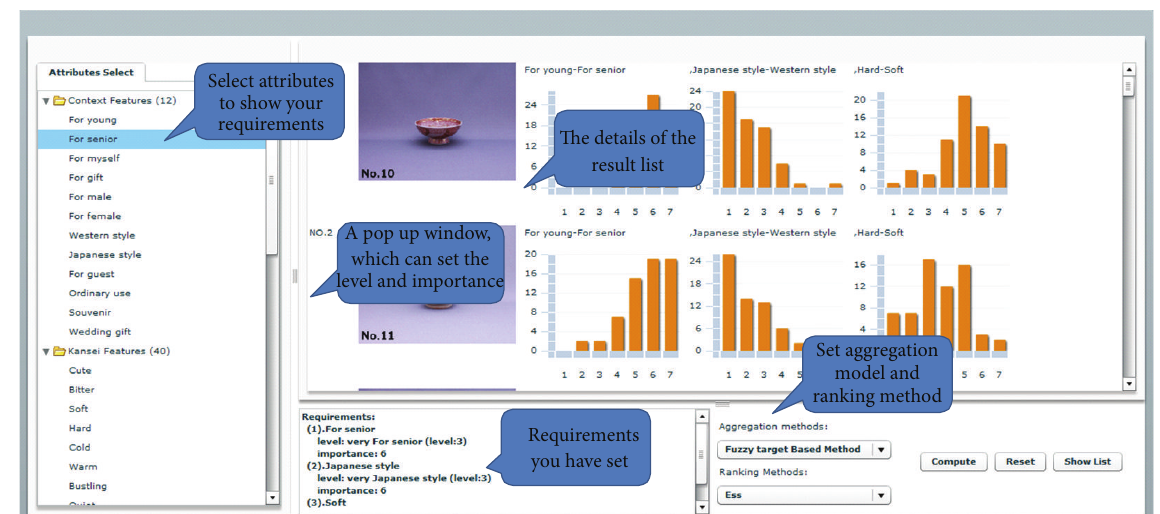
Figure 7: The interface of the recommendation